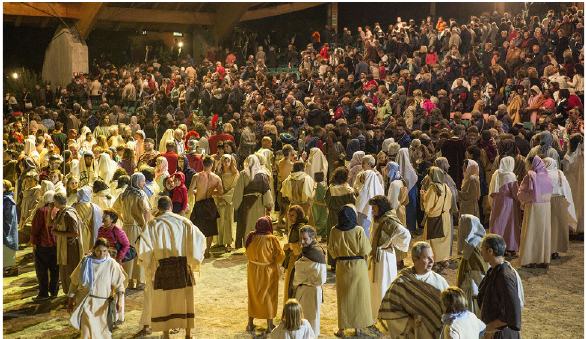
Figure 1 . Actors and public on the stage of the Passione di Sordevolo . © Foto Perini Biella